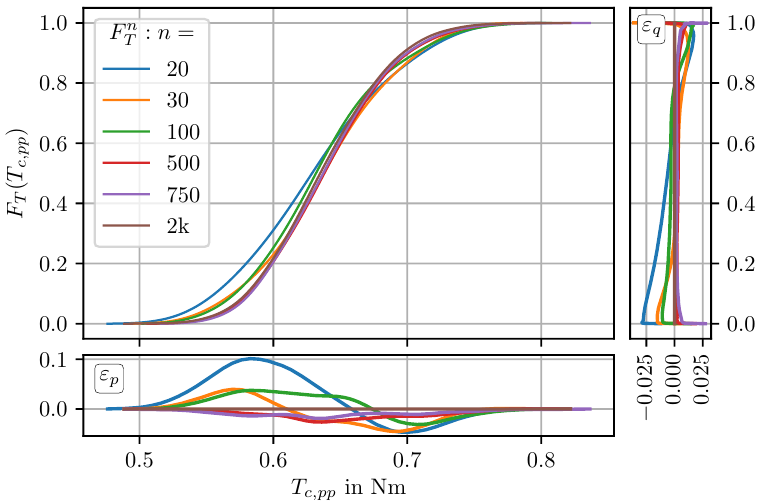
F 20 to the fitted CDF F 20 for the probability ε p , as well as for the T T 10 − 3 Nm. · (cid:98)